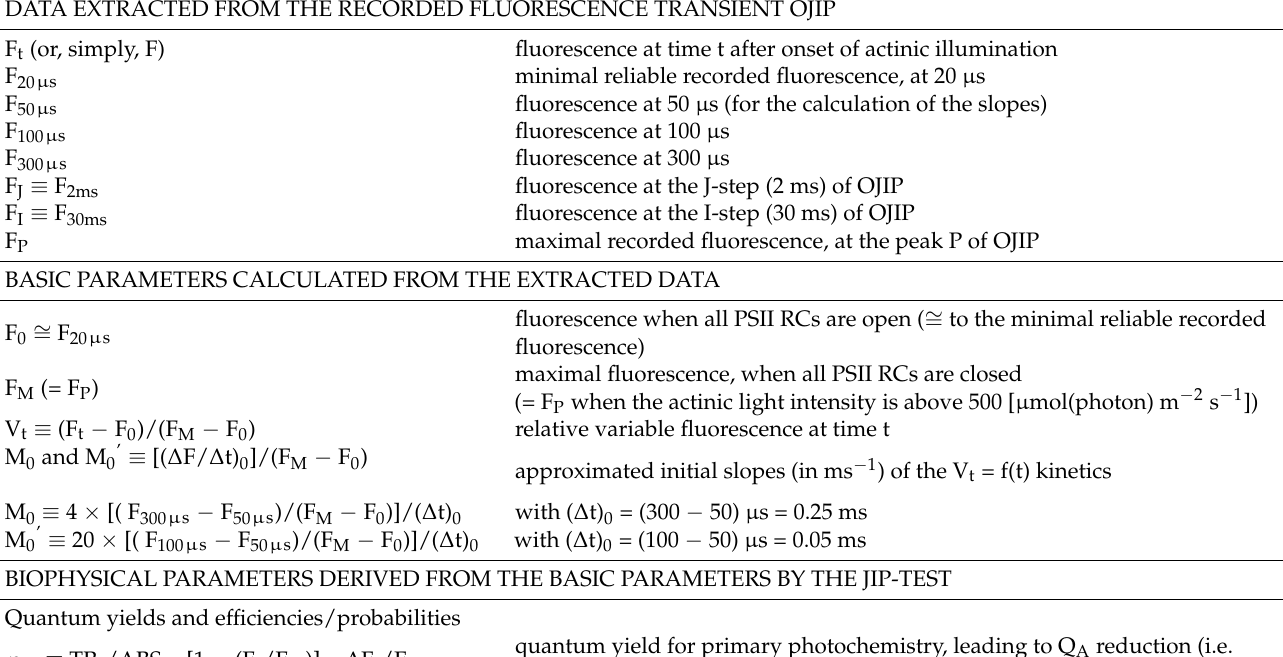
Table 1. Glossary, definition of terms and formulae of the JIP-test used for the analysis of the Chl a fluorescence transients OJIP